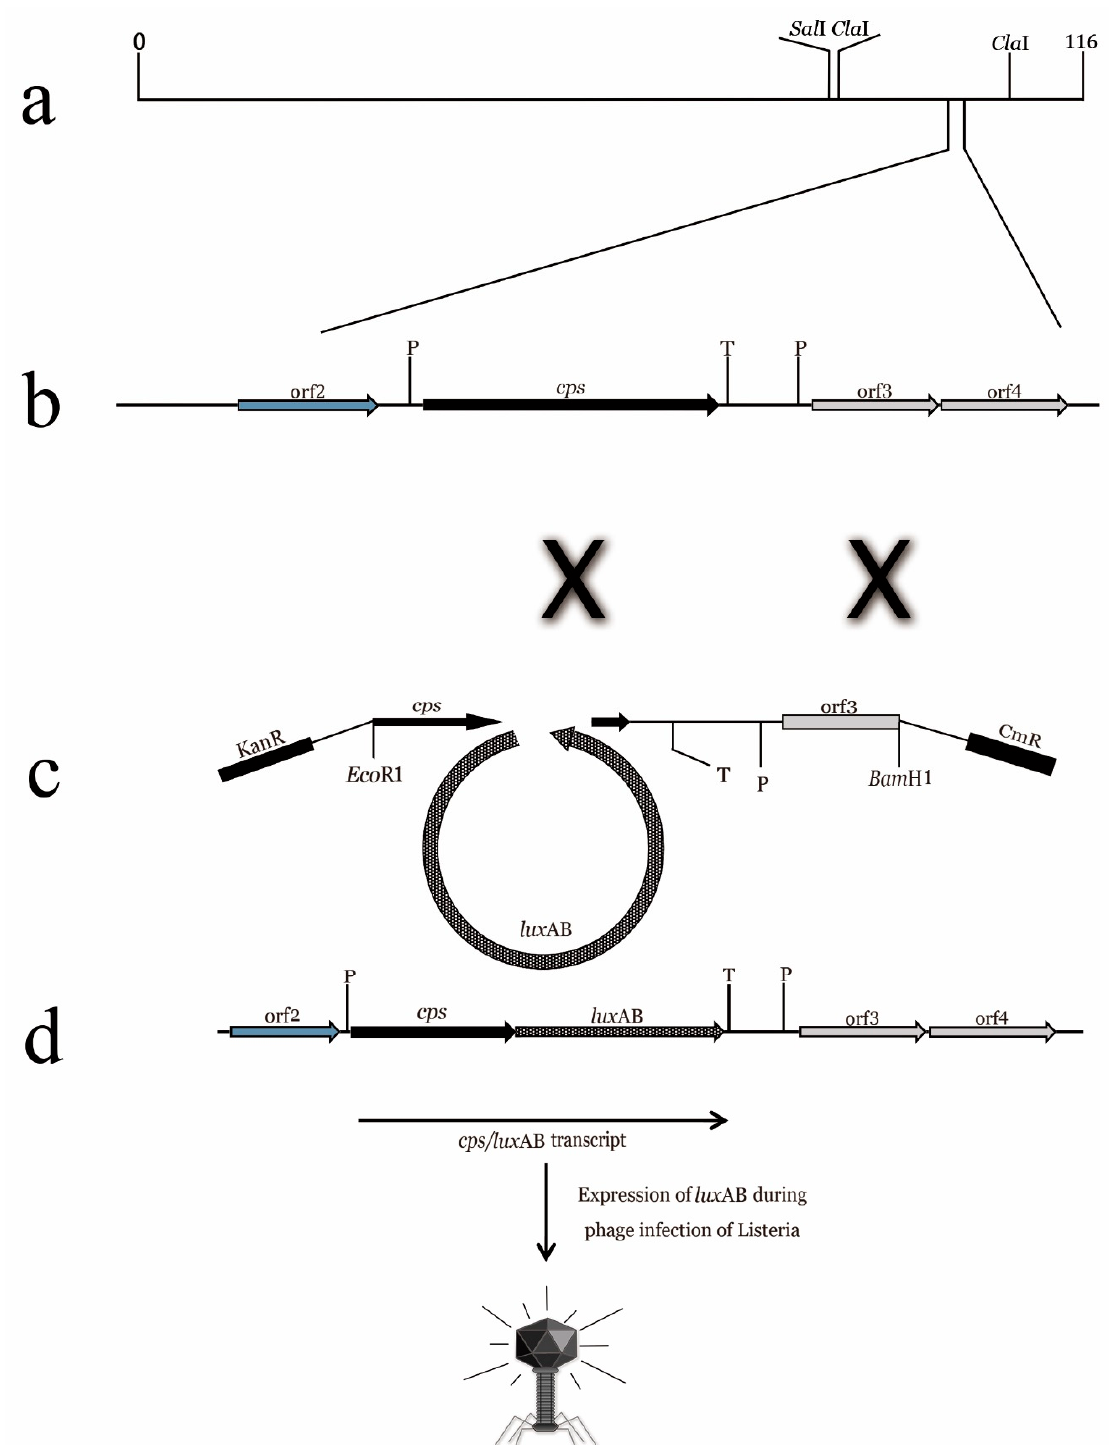
Figure 1. Preparation of “fluorescent phages” by homologous recombination. ( a ) Simplified Listeria A511 phage gene map; ( b ) a 5 KB fragment of A511 gene map. Proliferation markers indicate that the phage DNA in infected cells recombined with pcK511, -F3C, and -luxAB fragments (double crossover); ( c , d ) luxAB fragment binds between the 3 ′ end of CPS fragment and the downstream transcrip- tional terminator. Expression of the A511::luxAB gene produces CPS fragments fused with luciferase genes, resulting in infected listeria cells with bioluminescence phenotype [15].